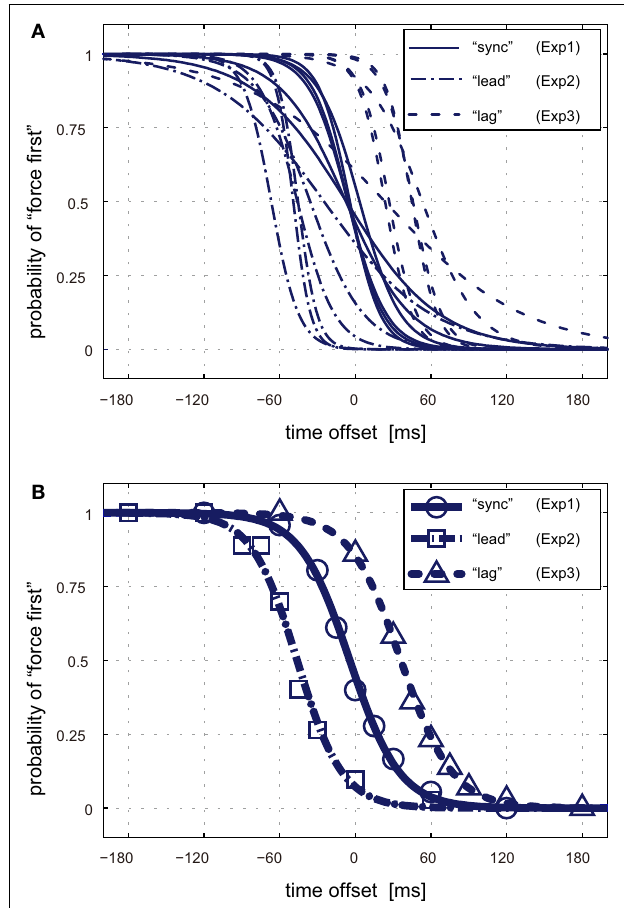
FIGURE 5 | Psychometric curves for temporal simultaneity. (A) Psychometric curves of each participant after “sync” (solid lines), “lead” (dash-dotted lines), and “lag” (dotted lines) conditioning.The horizontal axis represents time offset between load force exertion and visual contact. Negative or positive offsets indicate that force exertion preceded or followed visual contact, respectively.The vertical axis represents probability that the participants judged that load force was applied before visual contact. (B) Group-average psychometric curves after the three types of time offset conditioning. Circles, squares, and triangles represent the group-average probability for the “sync,” “lead,” and “lag” conditioning,